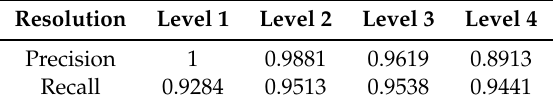
Table 7. The effect of resolution on our proposed